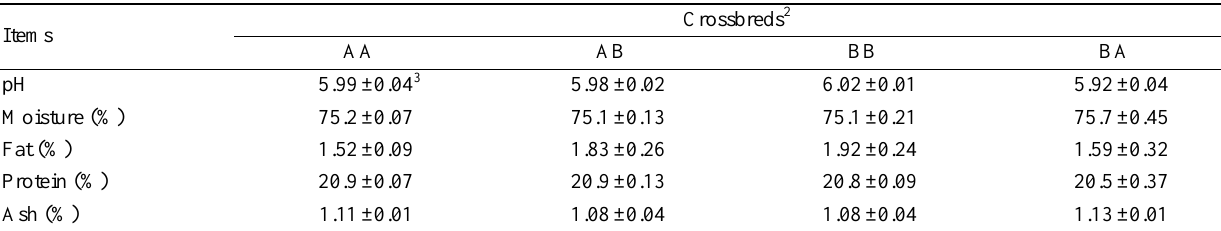
Table 8. Chemical composition of meat of commercial Korean native ducks 1 Items